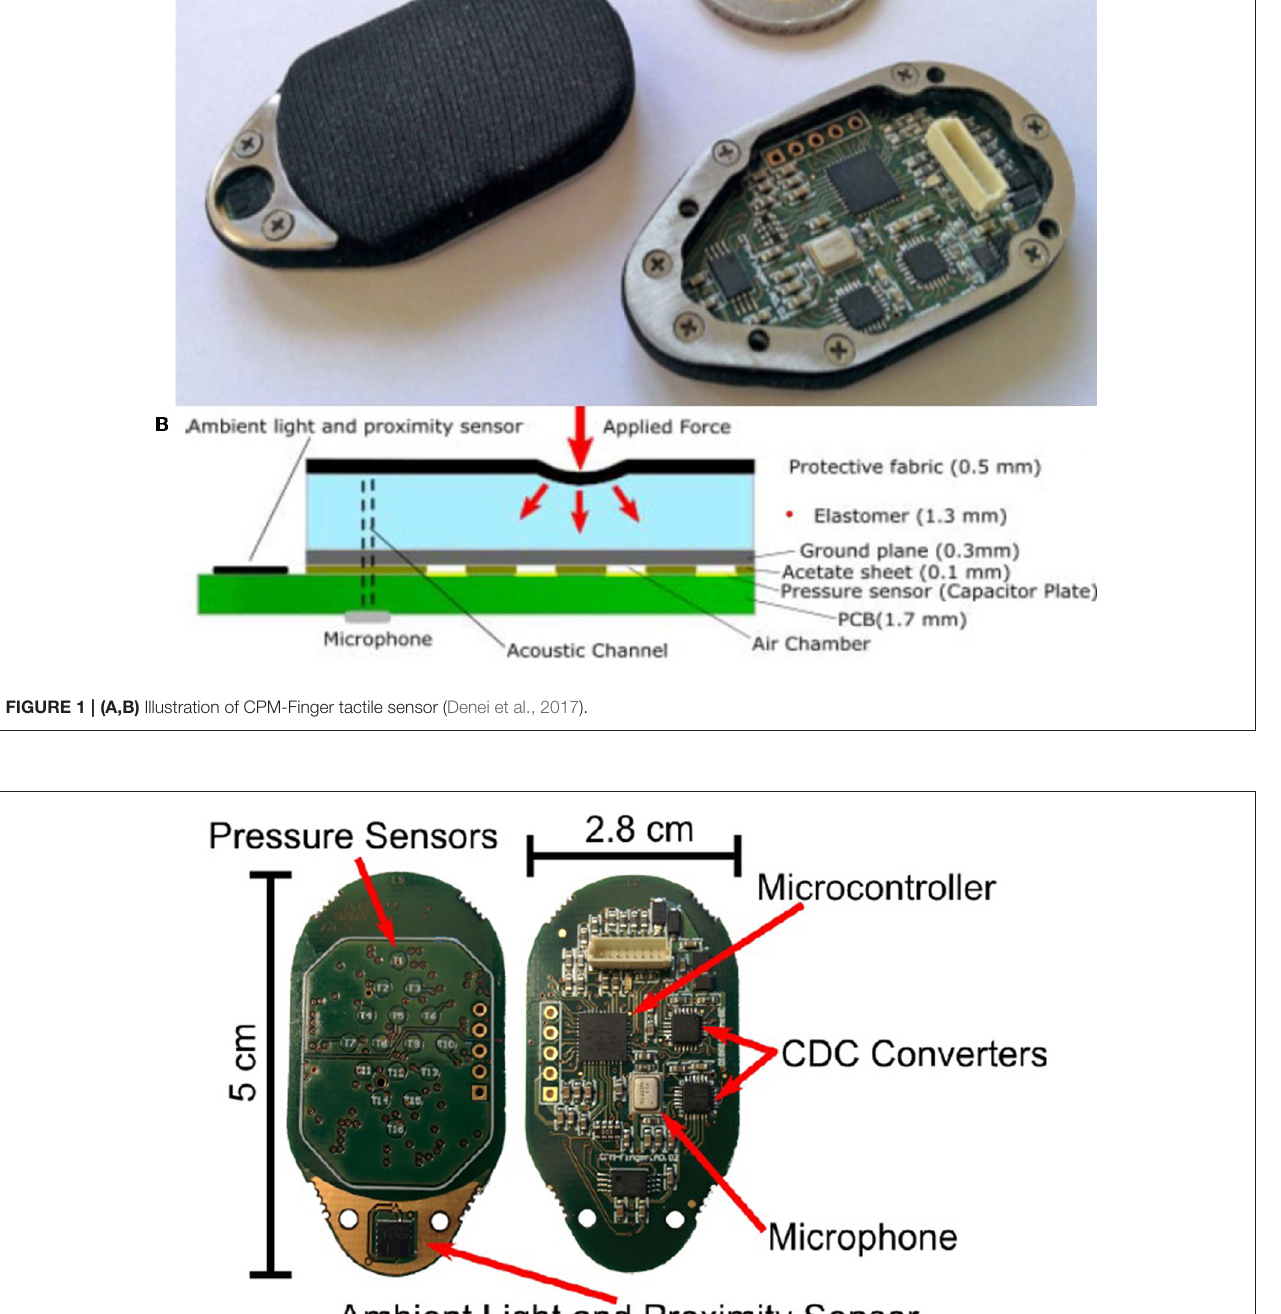
Frontiers in Neurorobotics |